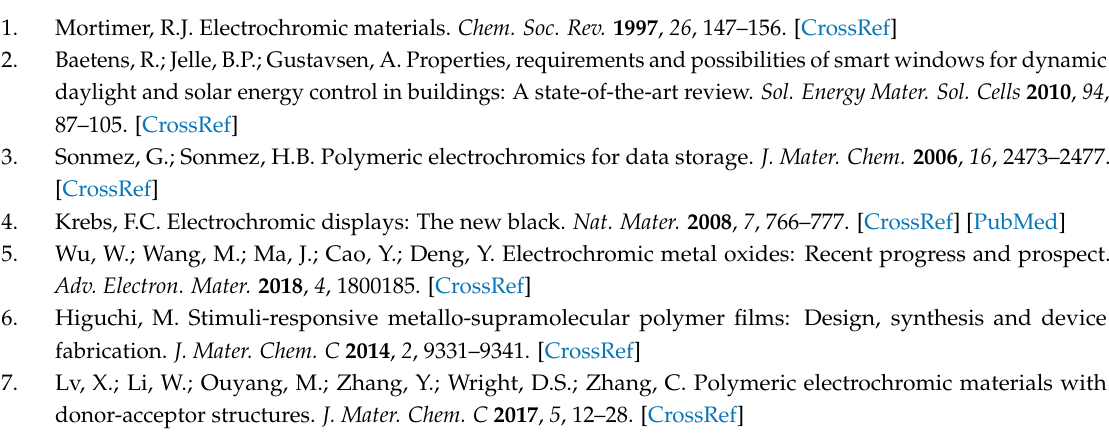
Figure S1. CVs recorded during the oxidative electropolymerization of 1 and 2 at different potential regions. Figure S2. SEM images of P1 /ITO glass film. Figure S3. Transmittance changes of P1 and P2 after 50 cycles of double-potential switching. Figure S4. 1 H NMR of compound 1 ; Figure S5. 1 H NMR of compound 2 ; Figure S6. HRMS data of compound 1 ; Figure S7. HRMS data of compound 2